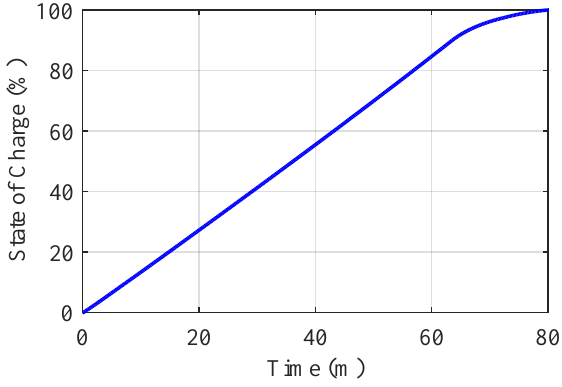
Figure 10. State of charge as a percentage of the battery capacity over the charging time.